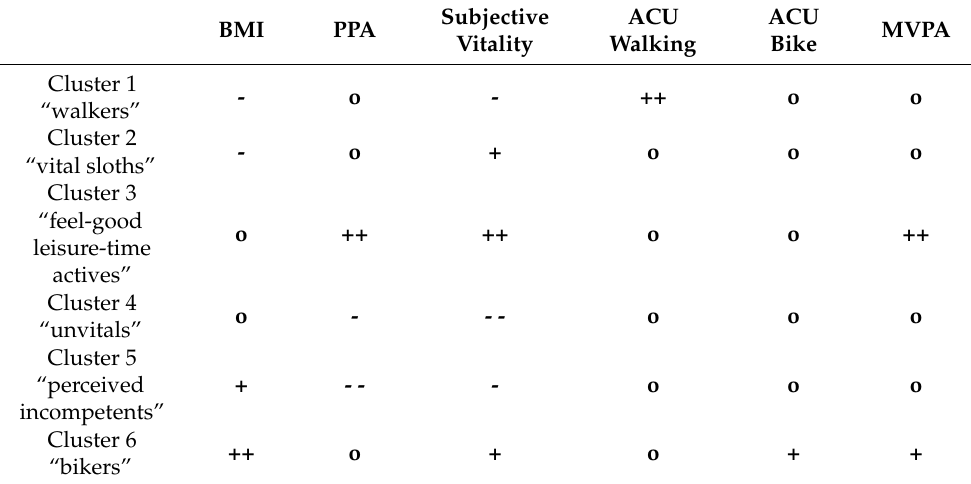
Table 3. Female clusters’ mean values in the input variables according to quintiles.